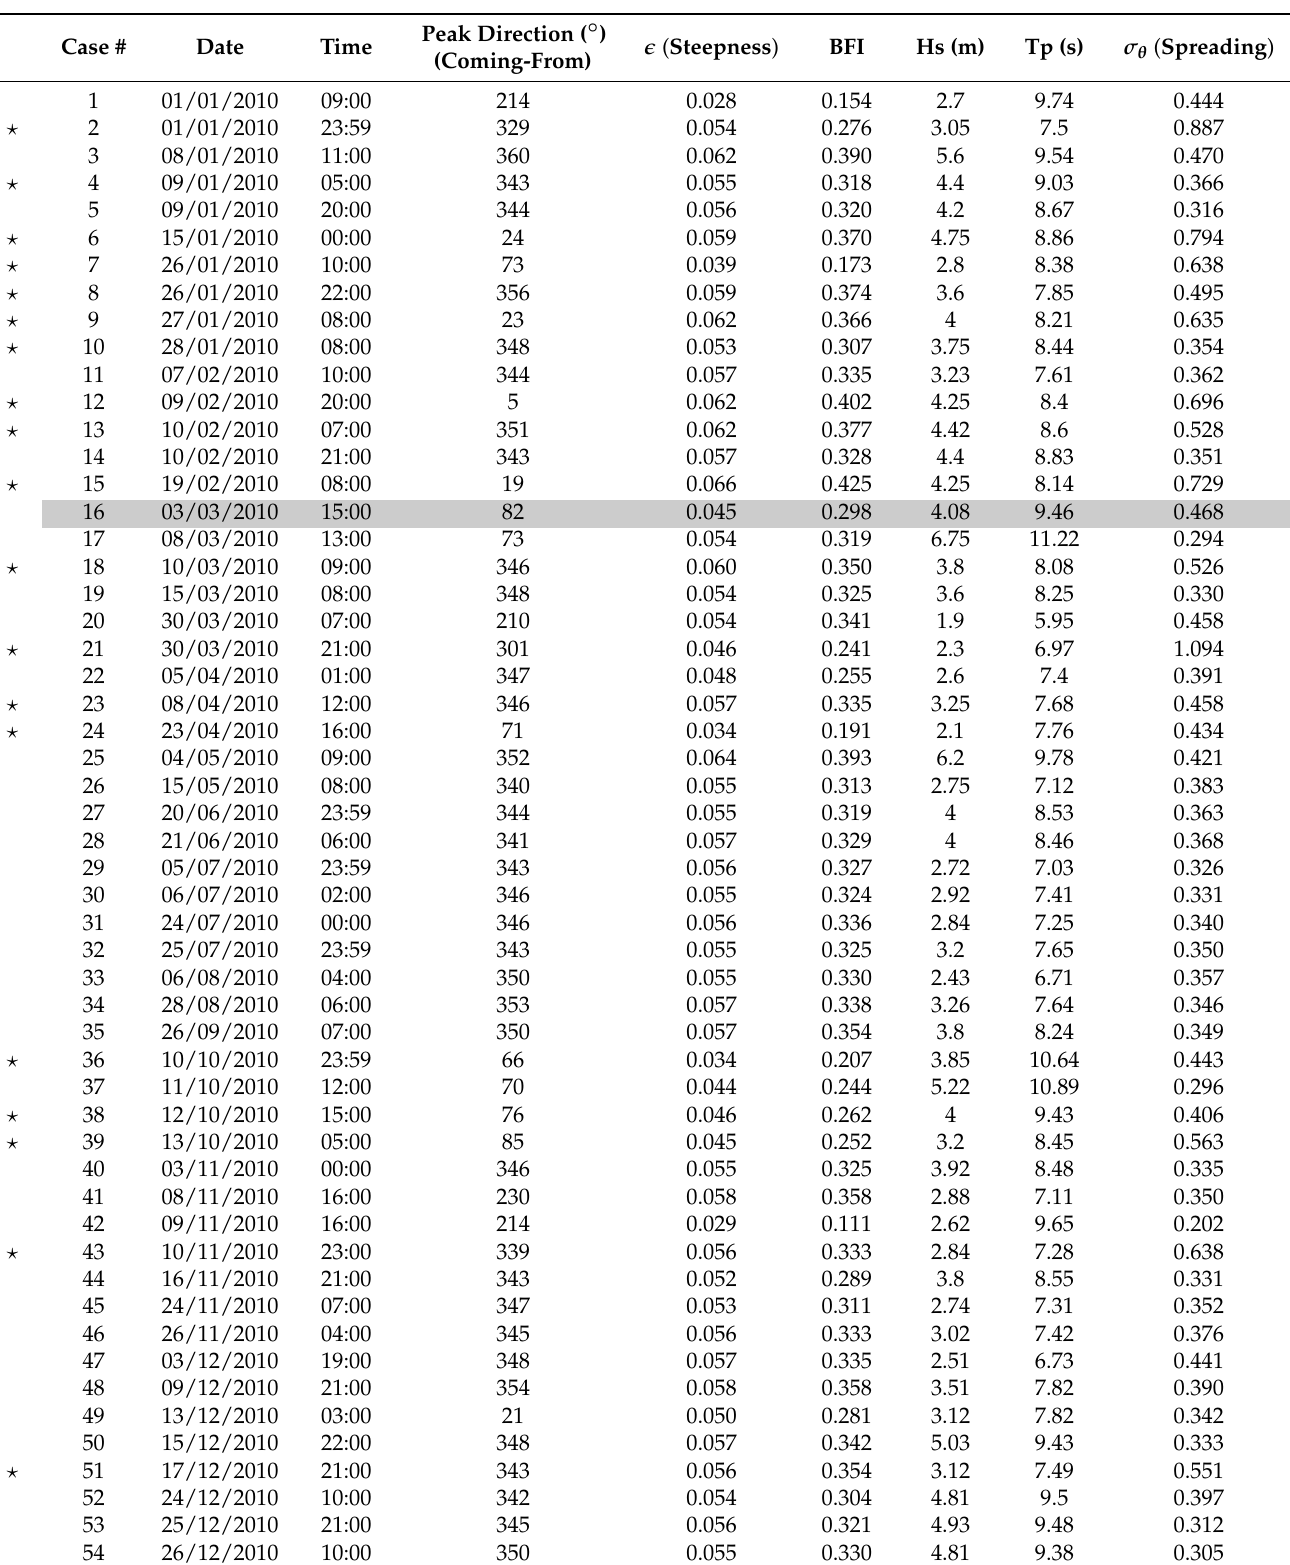
Table 1. List of the events simulated with HOS model with the respective average spectral quantities: peak direction (coming from), wave steepness (cid:101) , Benjamin–Feir Index (BFI), significant wave height H s , peak period T p and spectral angular spreading σ θ . (cid:63) denotes a crossing sea condition; the gray line corresponds to the Louis Majesty accident date and